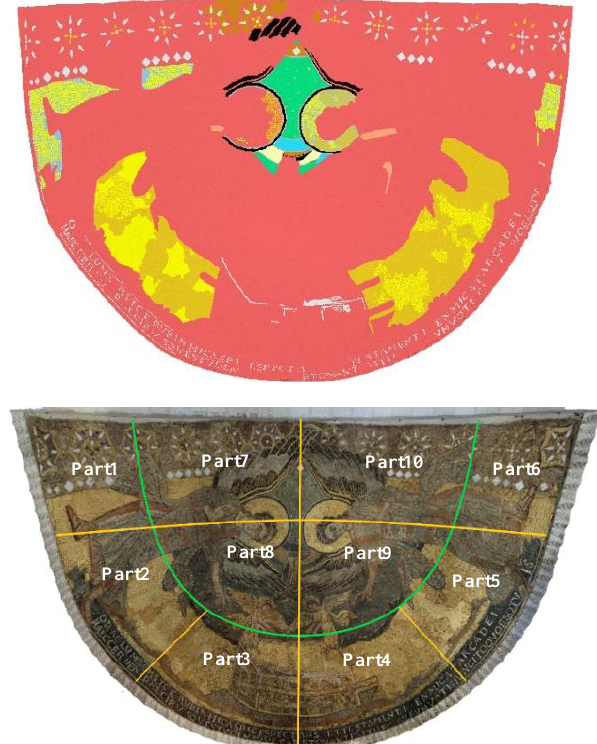
Figure 7. Labelled parts with different colour for each class (top), Overview of the approximate boundary of each section